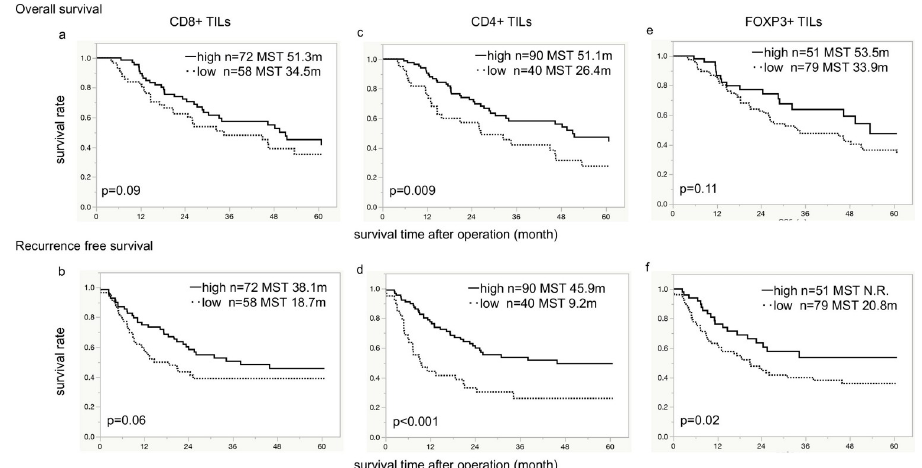
Fig 2. Overall survival and recurrence-free survival for tumor-infiltrating T cells. Kaplan-Meier survival curve indicates that the high-infiltrating CD4+ TILs group shows significantly superior OS and RFS than the low-infiltrating CD4+ TILs group. The high-infiltrating FOXP3+ TILs group shows significantly superior RFS than the low-infiltrating FOXP3+ TILs group. TILs: tumor-infiltrating lymphocytes, OS: overall survival, RFS: recurrence-free survival, MST: median survival time, N.R.: not reached.